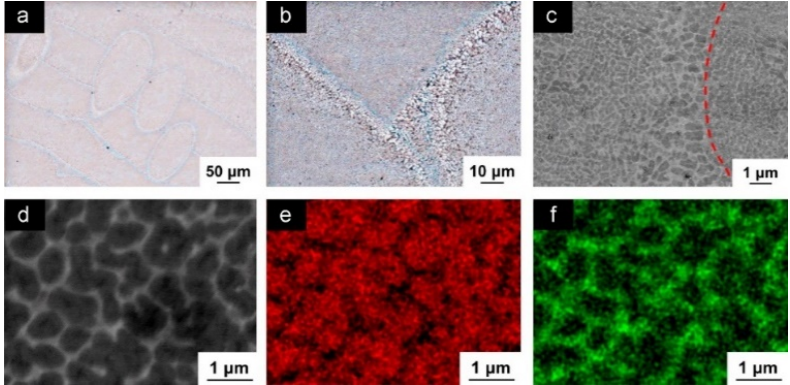
Figure 23. Microstructure of Al-12Si samples prepared by SLM with angle of inclination γ = 90 ◦ (i.e., perpendicular to the substrate plate): ( a , b ) OM and ( c , d ) SEM micrographs, and ( e , f ) EDX composition maps for Al (red) and Si (green), respectively [67]. Copyright 2013. Adapted with permission from Elsevier Science Ltd. under the license number 4803720747532 (Figure 1 [67]),